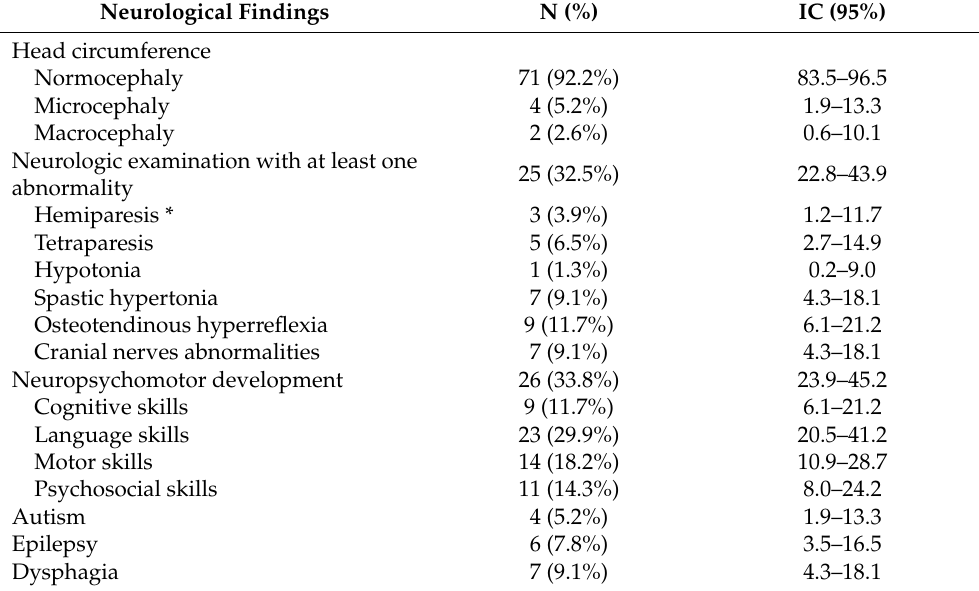
Table 3. Neurological outcomes related to neuropsychomotor development and physical examination at the end of the follow-up period of 77 children exposed to Zika virus in the intrauterine period, Manaus, Brazil.